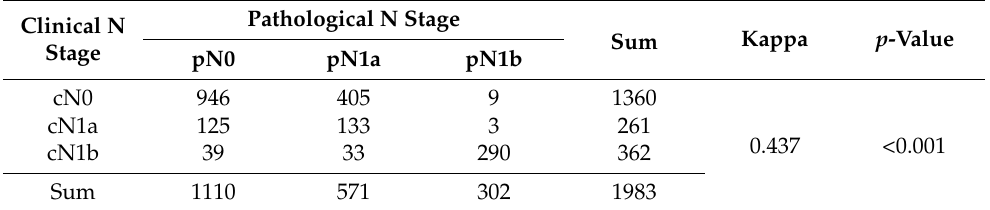
Table 2. Preoperative ultrasound N staging and pathological N staging results of patients with thyroid